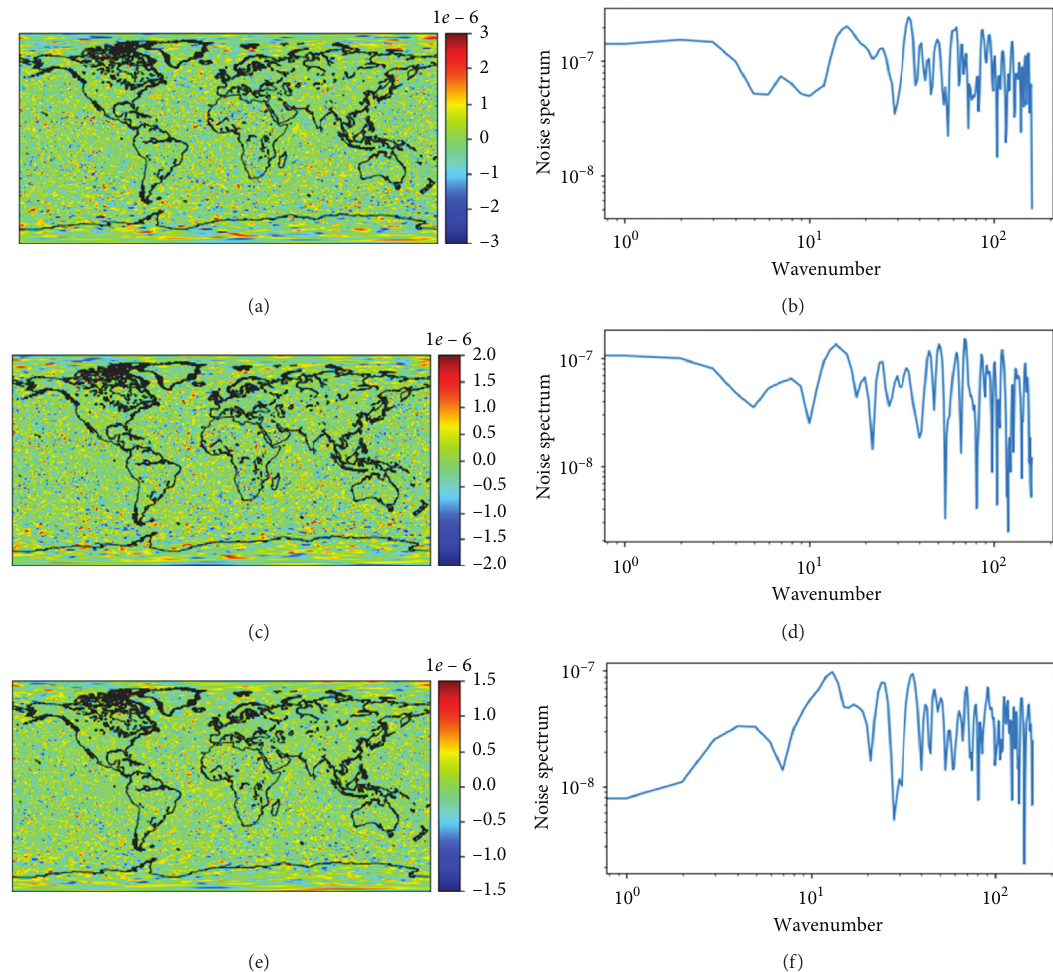
Figure 2: The noise of the vorticity standard deviation field at 1000hPa calculated from 50 samples and the corresponding energy spectrum (first row), 100 samples (second row), and 200 samples (third